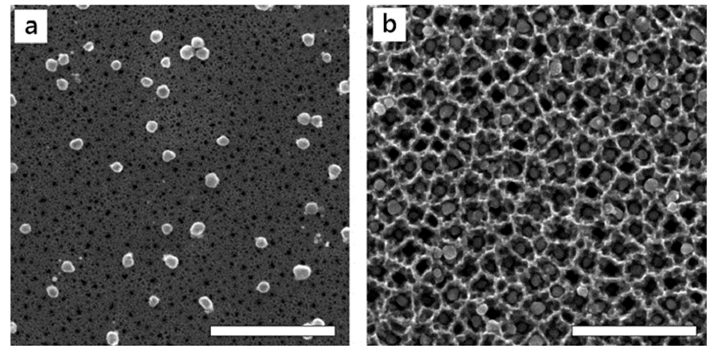
Figure 7. Top view of the initial ( a ) and the RIE-etched PS ( b ) made in 10 wt.% HF solution and at j = 100 mA/cm 2 after Ag nanoparticles deposition. The scale bar is 500 nm.